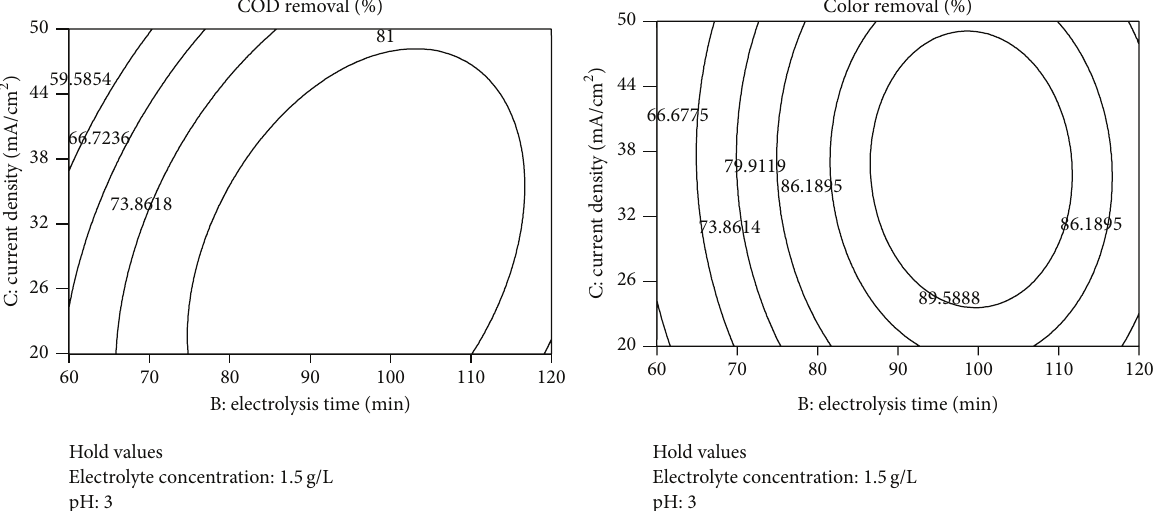
Figure 7: Contour plots between electrolysis time and current density for the responses.